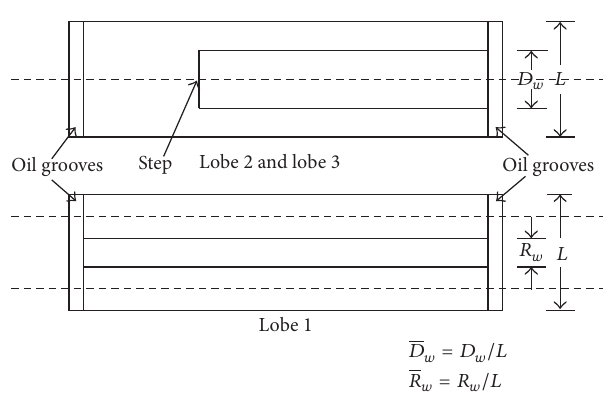
depth on the steady-state and dynamic characteristics of two- lobe and three-lobe pressure dam